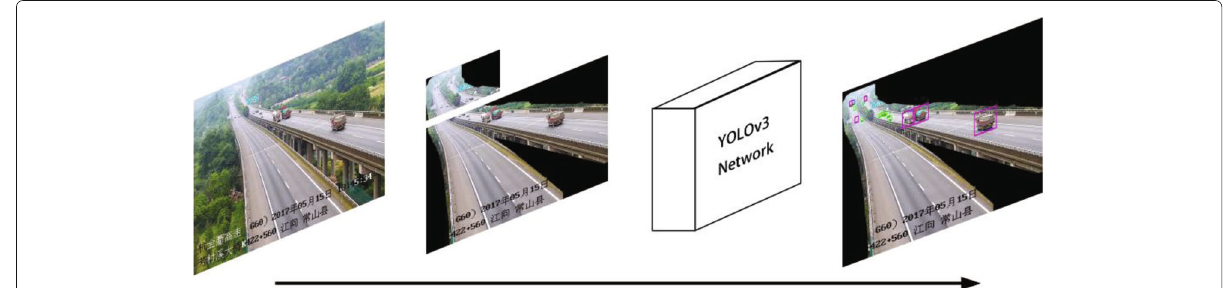
Fig. 9 Segmented image sent to the detection network and detected results merging. (Green, blue, and fuchsia boxes are labelled to indicate the “car”, “bus”, and “truck” regions, respectively.)